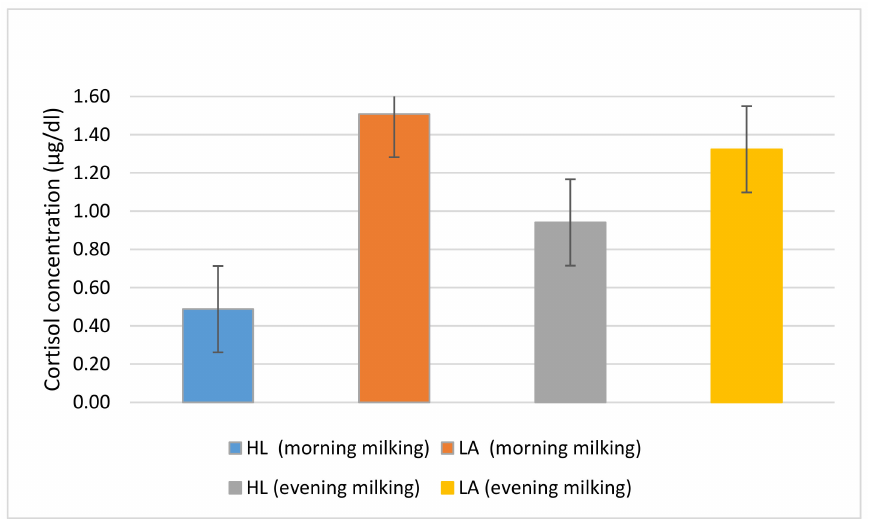
Figure 6. Cortisol concentration ( µ g/dL) in blood of cows by health status and milking. HL—healthy group; LA—lameness